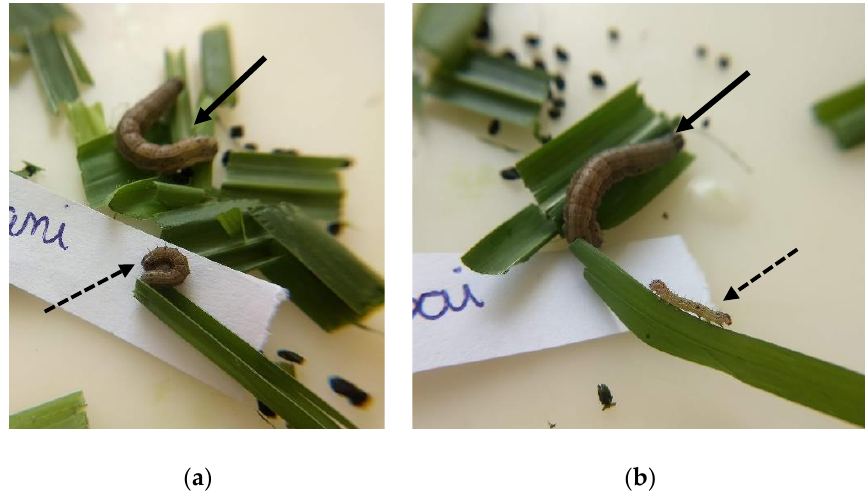
Figure 5. Spodoptera frugiperda larvae at 10 days of development on ( a ) Brachiaria ruziziensis (bold arrow) , Panicum maximum ‘ Tamani’ (dotted arrow) , and ( b ) Brachiaria ruziziensis (bold arrow) , Panicum maximum ‘ Massai’ (dotted arrow) .